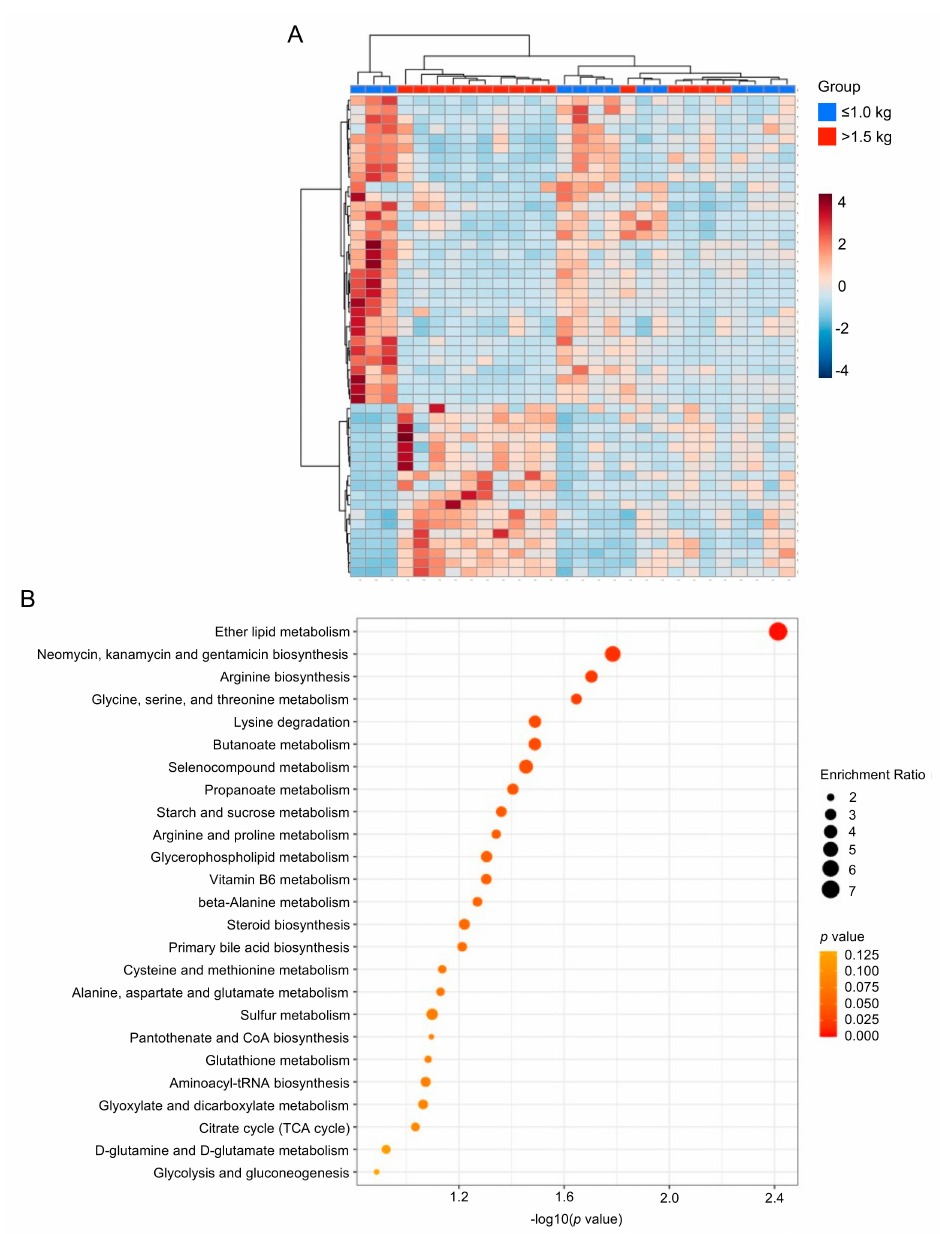
Figure 2. Heat map and enrichment analysis of control group human milk samples. ( A ) Hierarchical clustering heat map of the top 50 differentially expressed metabolites in the ≤ 1.0 kg (blue) versus >1.5 kg (red) birth weight control groups by T-test. ( B ) Quantitative enrichment analysis reveals the top 25 enriched metabolite sets in the milk of mothers with infants ≤ 1.0 kg birth weight compared with >1.5 kg birth